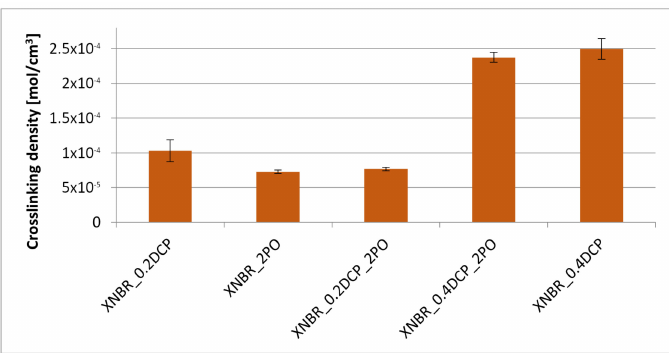
Figure 7. Influence of the modified resin addition on the crosslink density of